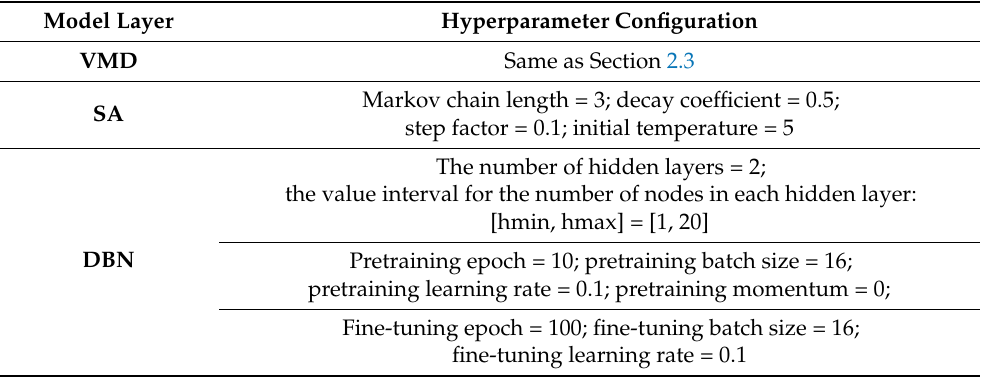
Table 2. Hyperparameter configuration in the VMD-SA-DBN